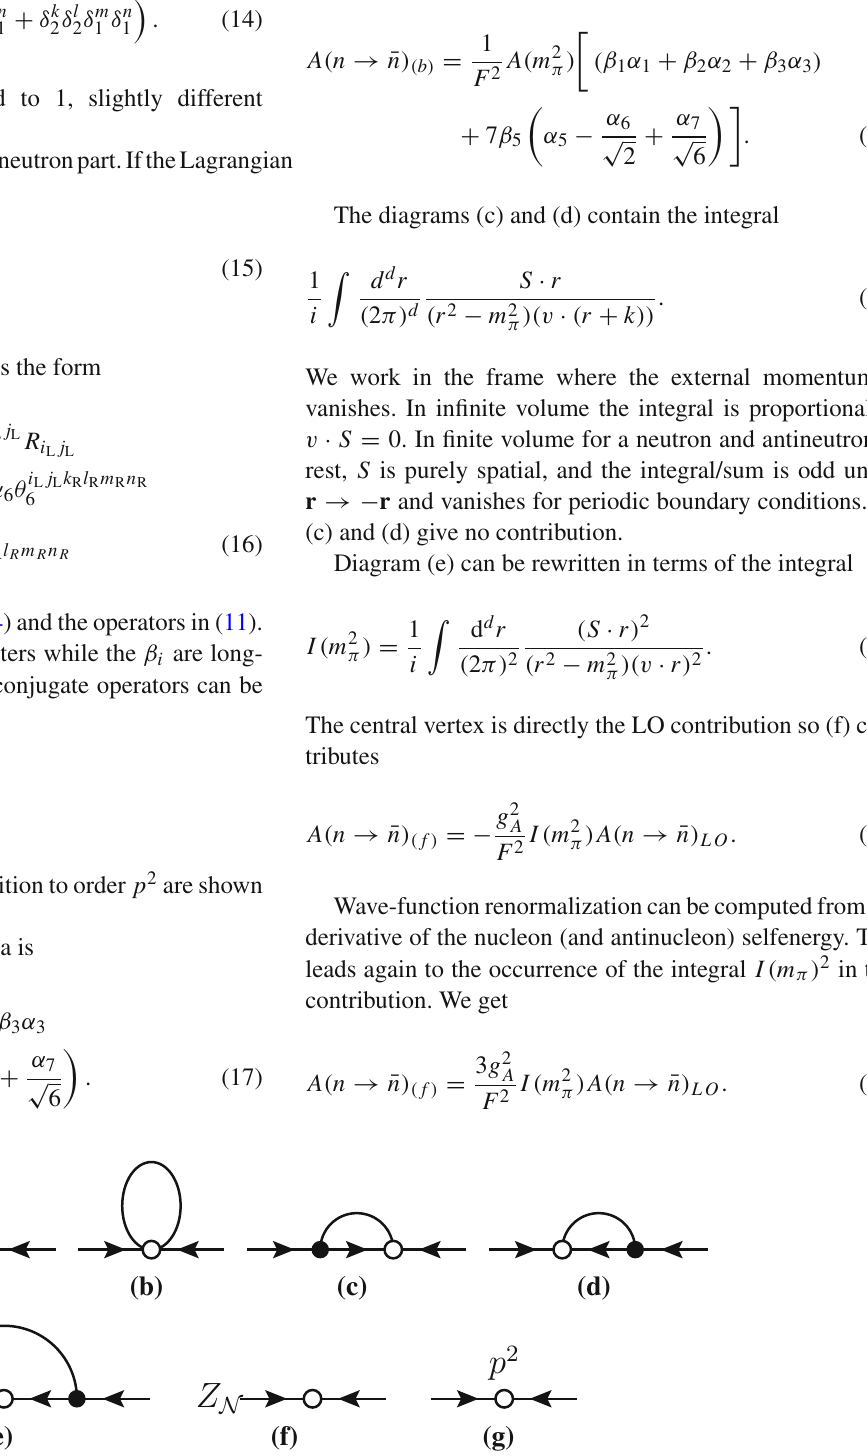
Fig. 2 The diagrams for n ¯ n transitions to order p 2 . An open dot indi- cates a vertex from the n ¯ n Lagrangian (16), a dot from the LO normal Lagrangian (7). The contributions from wave-function renormalization